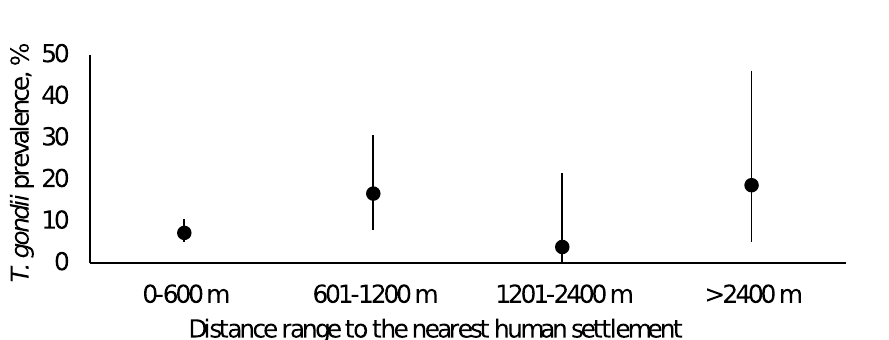
Figure 2. Prevalence of T. gondii B1-positive small mammals in each distance range to the nearest human settlement. Observed prevalence (black circles) and 95% confidence intervals (black lines) are